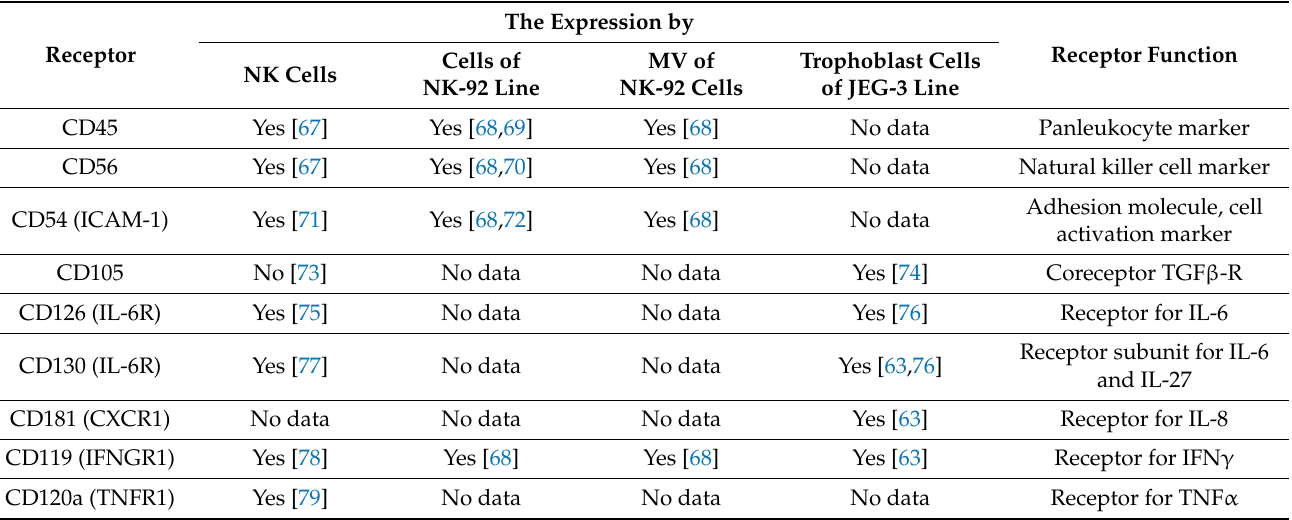
Table 1. The expression of some receptors by natural killers, NK-92 cells and their microvesicles, and JEG-3